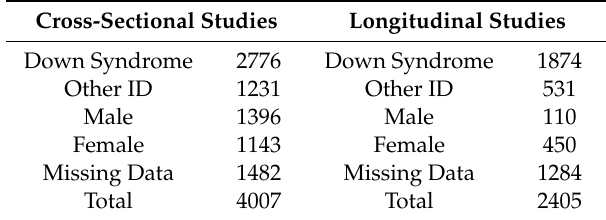
Table 1. Demographics of included individuals in the eligible